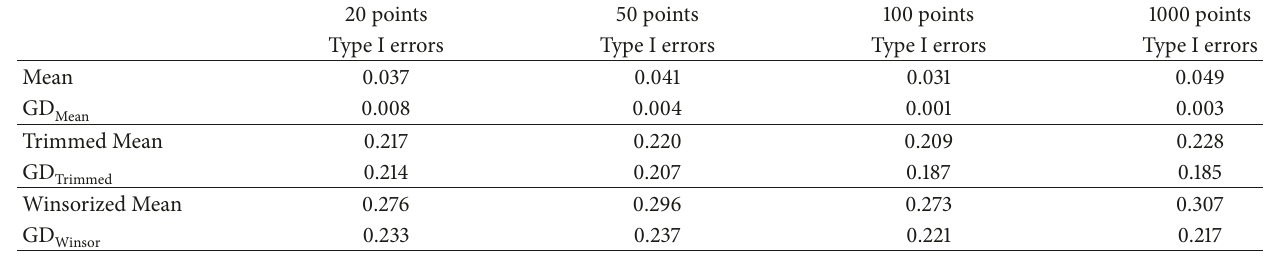
Table 60: G-h distributions with 30% noise level.